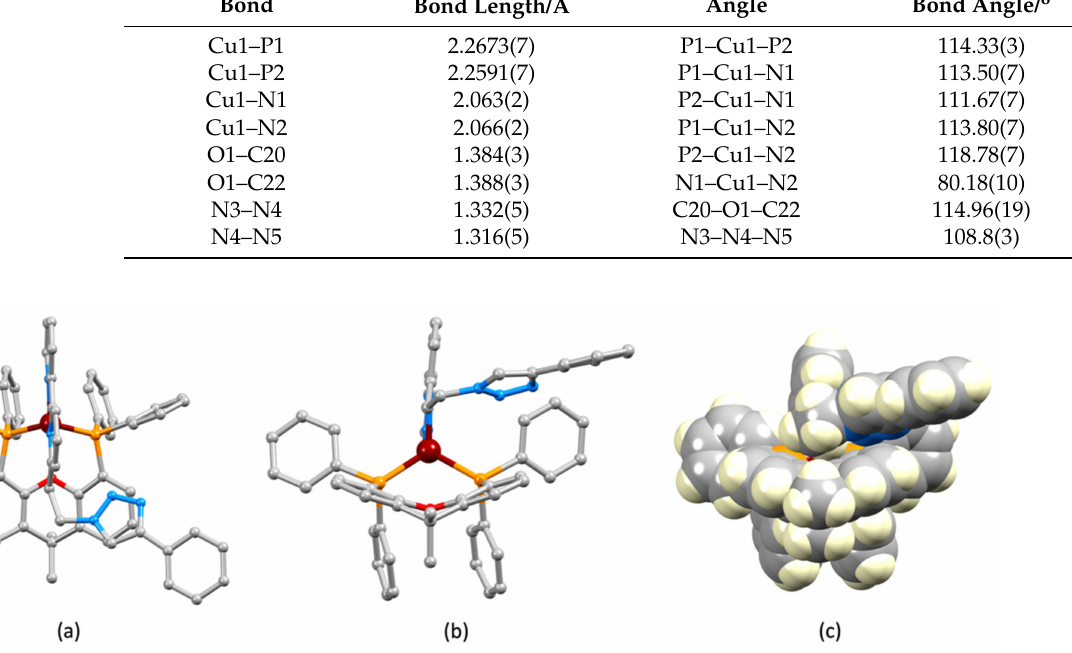
Figure 2. ( a , b ) Two views of the [Cu(xantphos)( 3 )] + cation, and ( c ) a space-filling representation of diagram ( b